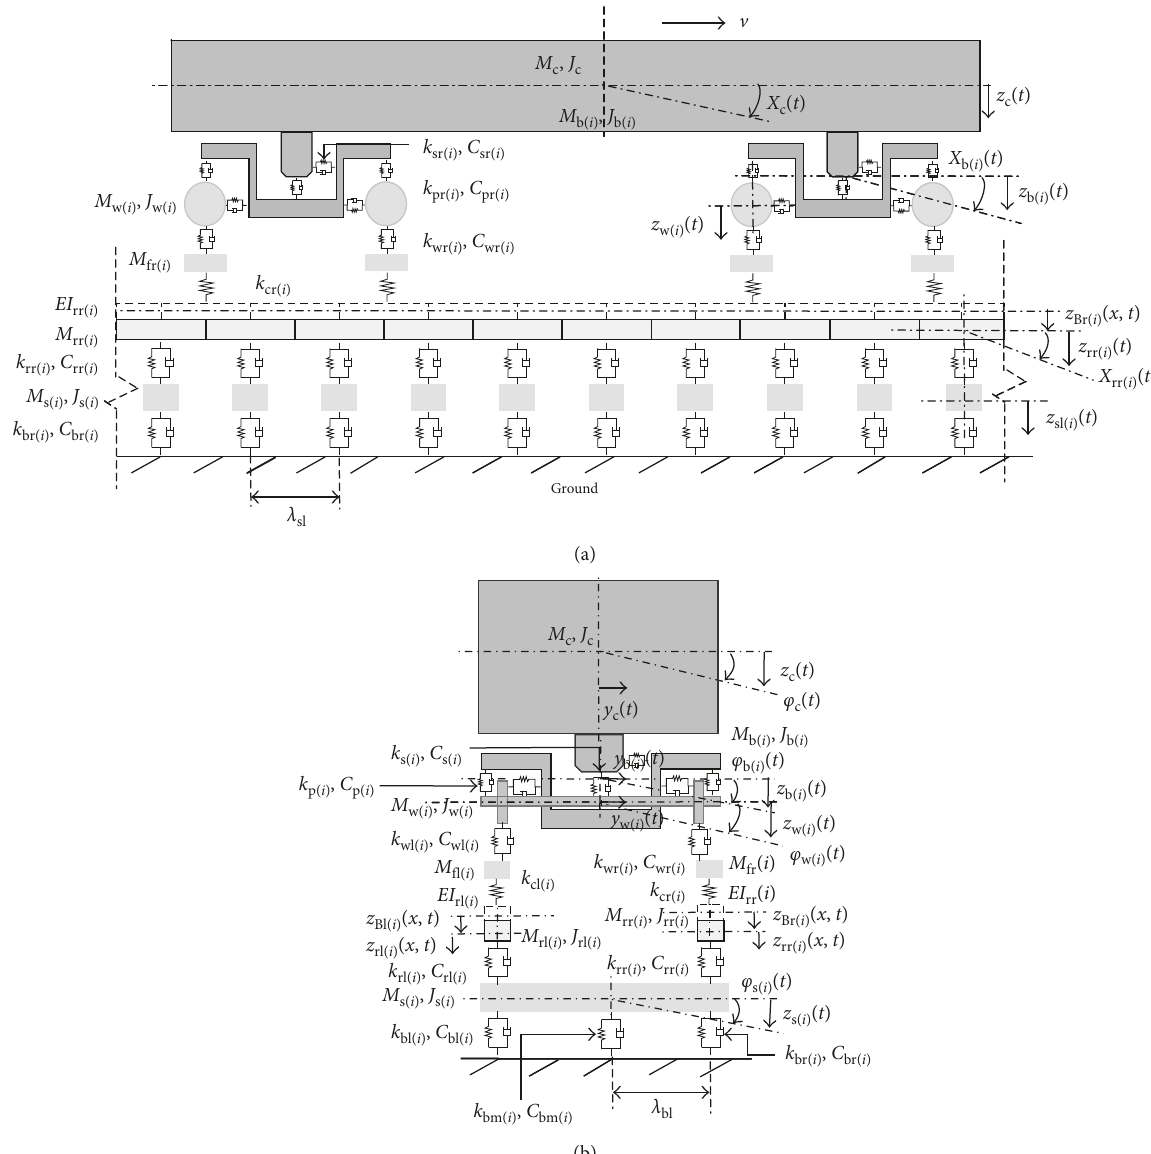
Figure 1: Schematic drawing of the train-track model (not to scale): (a) side view and (b) rear view. v : wheelset velocity, EI : rail bending r : railpad stiffness, second subscript r : right position, c : railpad damping, second subscript m : middle stiffness, second subscript l : left position, k r r position, k : ballast stiffness, subscript i : item number, c : ballast damping, M : carbody mass, z : carbody vertical displacement, J : carbody b b c c c : bogie vertical displacement, M : bogie mass, z : wheelset vertical displacement, J : bogie mass inertia, z : sleeper mass vertical mass inertia, z b b w b s displacement, M : wheelset mass, y : carbody lateral displacement, J : wheelset mass inertia, y : bogie lateral displacement, M : fictitious rail w c w b f : wheelset lateral displacement, M : rail mass, z : rail (beam) vertical displacement, J : rail mass inertia, z : rail mass vertical mass, y w r B r r displacement, M : sleeper mass, φ : carbody roll rotation, J : sleeper mass inertia, φ : bogie roll rotation, k : secondary suspension stiffness, φ : s s s c b w : secondary suspension damping, φ : sleeper mass roll rotation, k : primary suspension stiffness, χ : carbody mass pitch wheelset roll rotation, c s p s c rotation, c : primary suspension damping, χ : bogie mass pitch rotation, k : wheel-fictitious rail contact stiffness, χ : rail mass pitch rotation, c : p w w b r : sleeper distance, k : fictitious rail-rail contact stiffness, and λ : ballast support wheel-fictitious rail contact damping, λ sl c bl